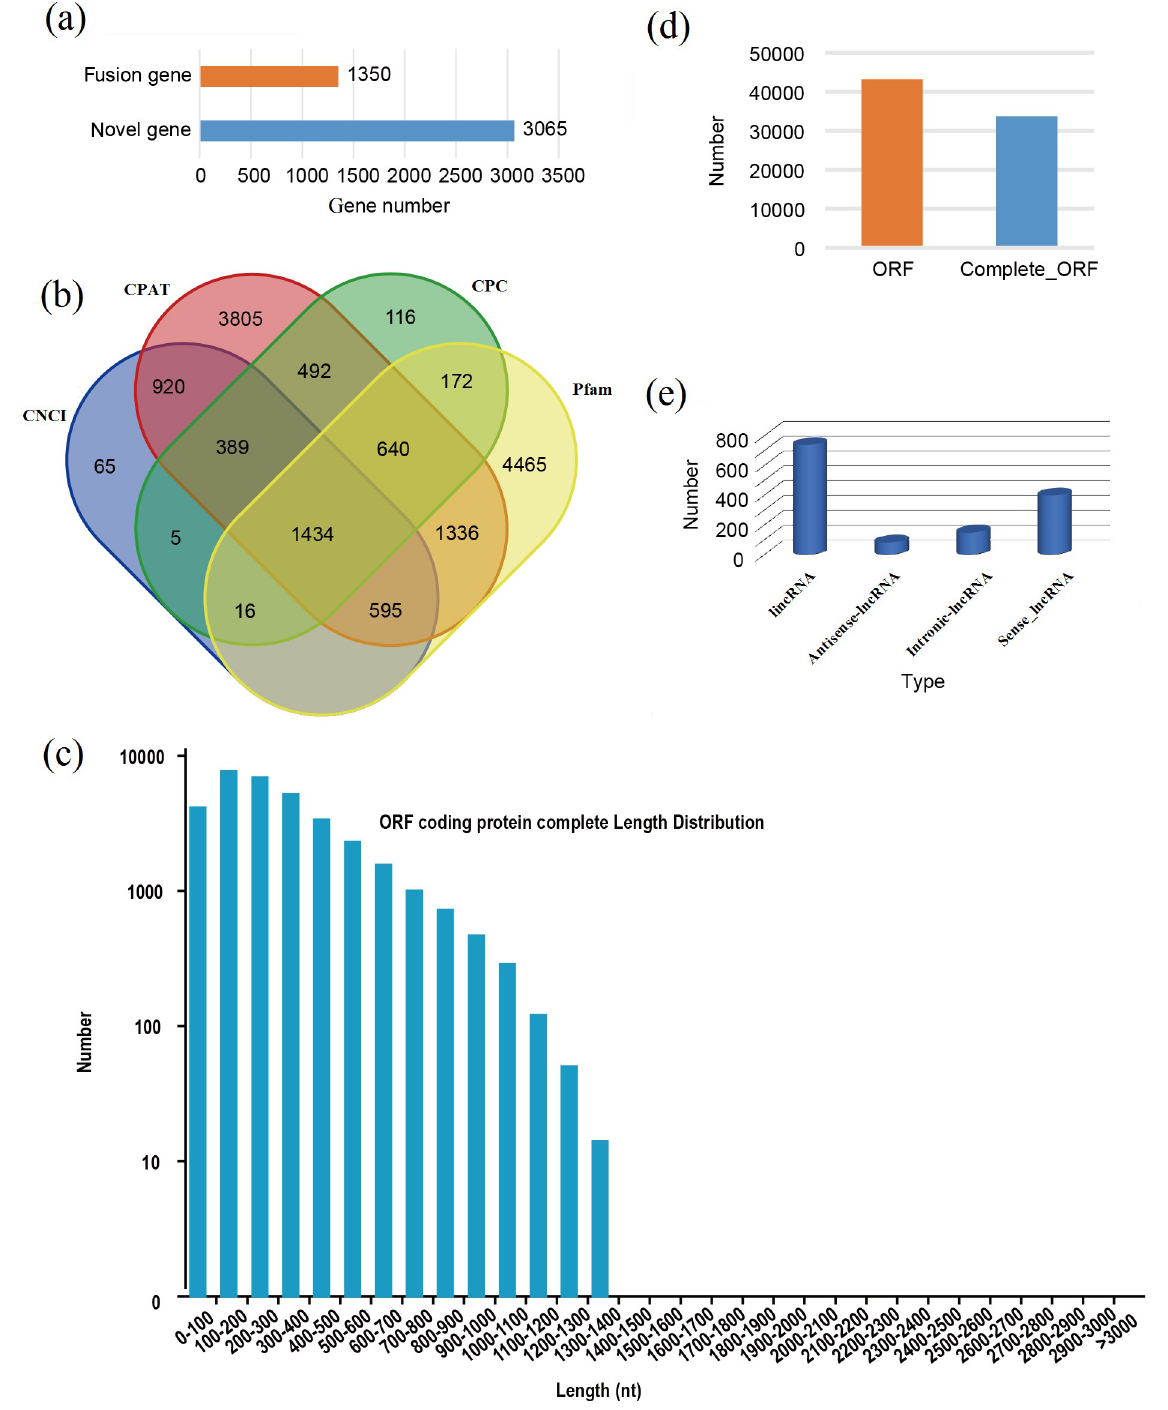
Fig 2. Identification of fusion genes, novel genes, lncRNAs, alternative splicing events and ORF numbers based on SMRT-based RNA sequencing. (a) numbers of fusion genes and novel genes, (b) Number of lncRNAs analyzed by pfam, cpat, cnci and cpc based on PacBio platform, (c) ORF coding protein complete length distribution, (d) numbers of ORF and complete ORF, (e) number and type of lncRNA. lncRNA, long non-coding RNA.